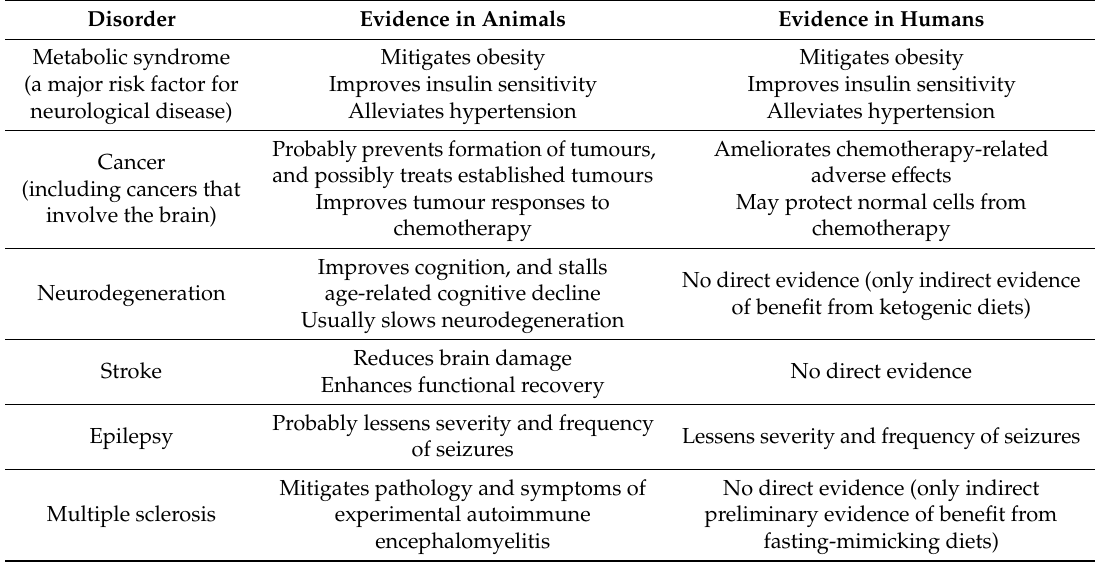
Table 2. Summary of evidence for fasting as a therapy in the prevention and treatment of common neurological diseases (in both animals and